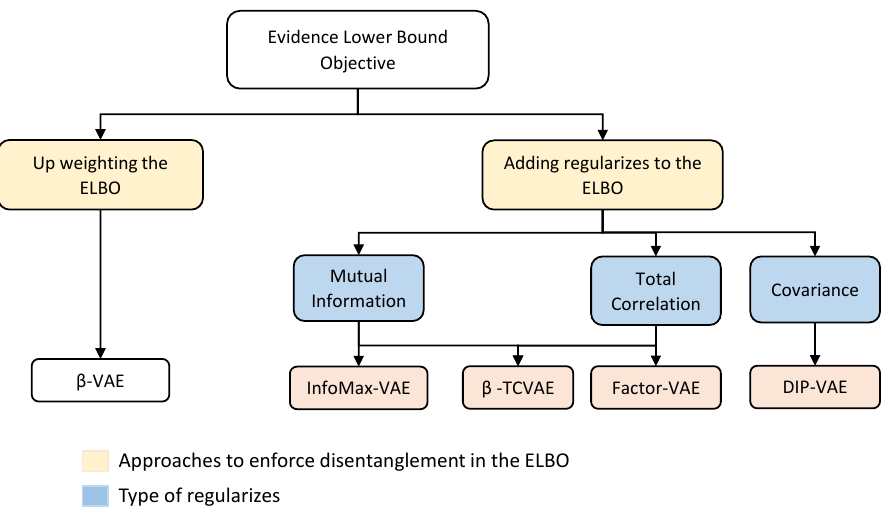
Figure 3. Schematic overview of different choices of augmenting the evidence lower bound of VAE. To improve disentanglement, most approaches focus on regularizing the original VAE objective by (i) up-weighting the ELBO with an adjustable hyperparameter β , resulting in a β -VAE approach. (ii) Adding different terms to the ELBO, such as mutual information, total correlation or